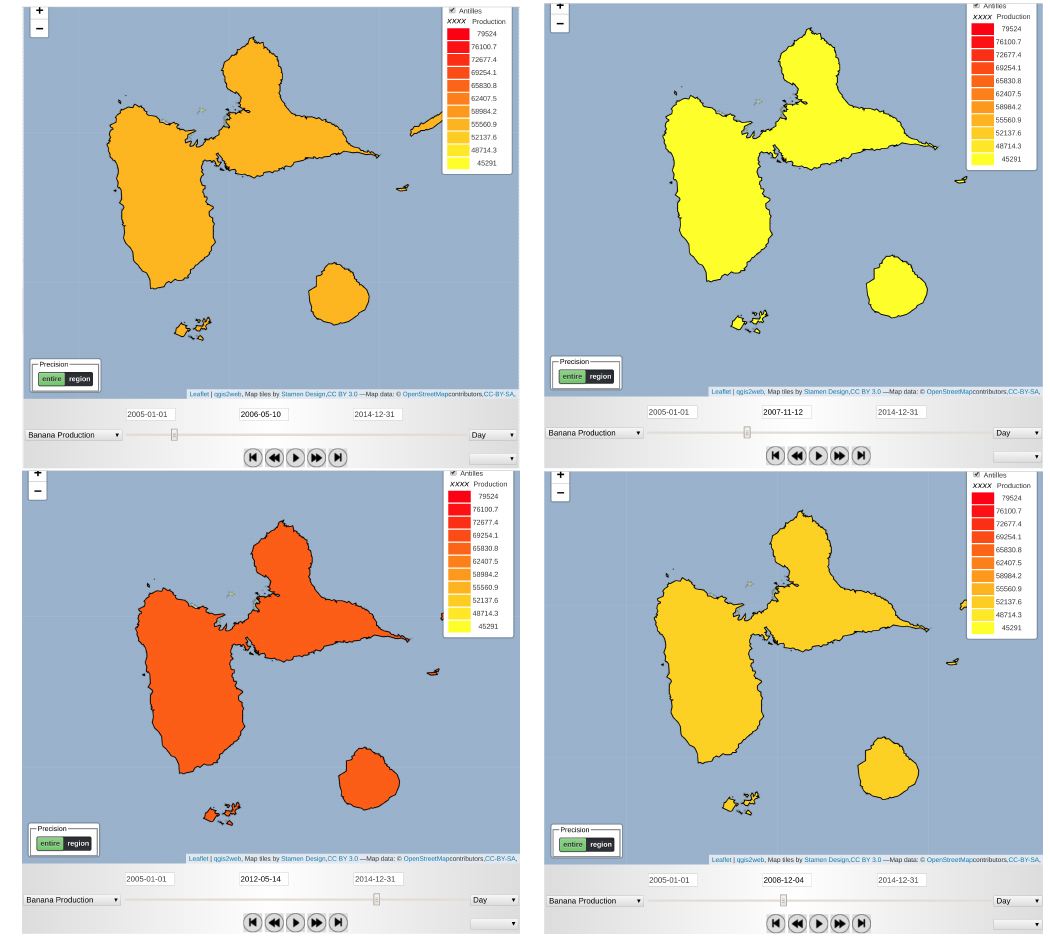
Figure 7. Visualization of crop production over time (simulation).